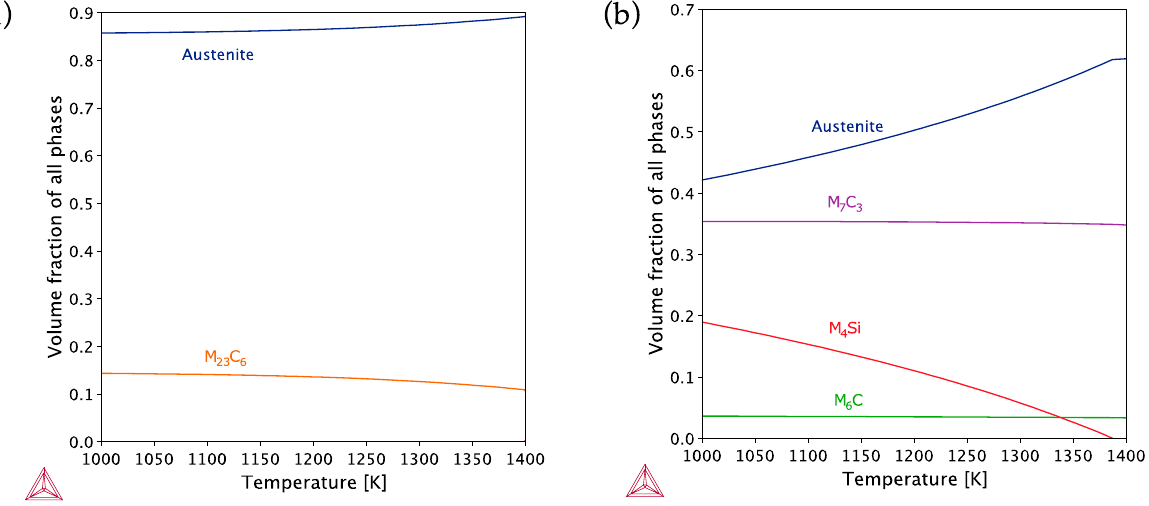
Figure 4. Property diagram of 316L with ( a ) 1.5 wt.% and ( b ) 7 wt.% PCS. M23C6, M7C3, and M6C phases listed represent carbides from the metals of the alloy of several compositions (mostly chromium), but none corresponds to SiC. chromium), but none corresponds to